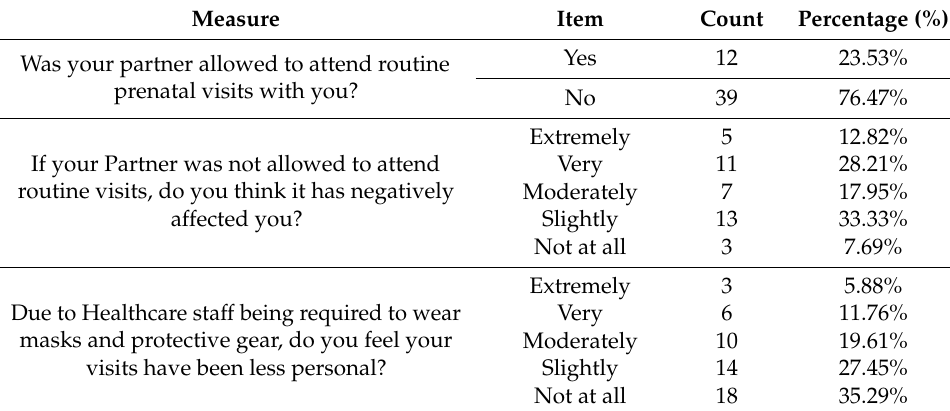
Table 3. Attitudes and